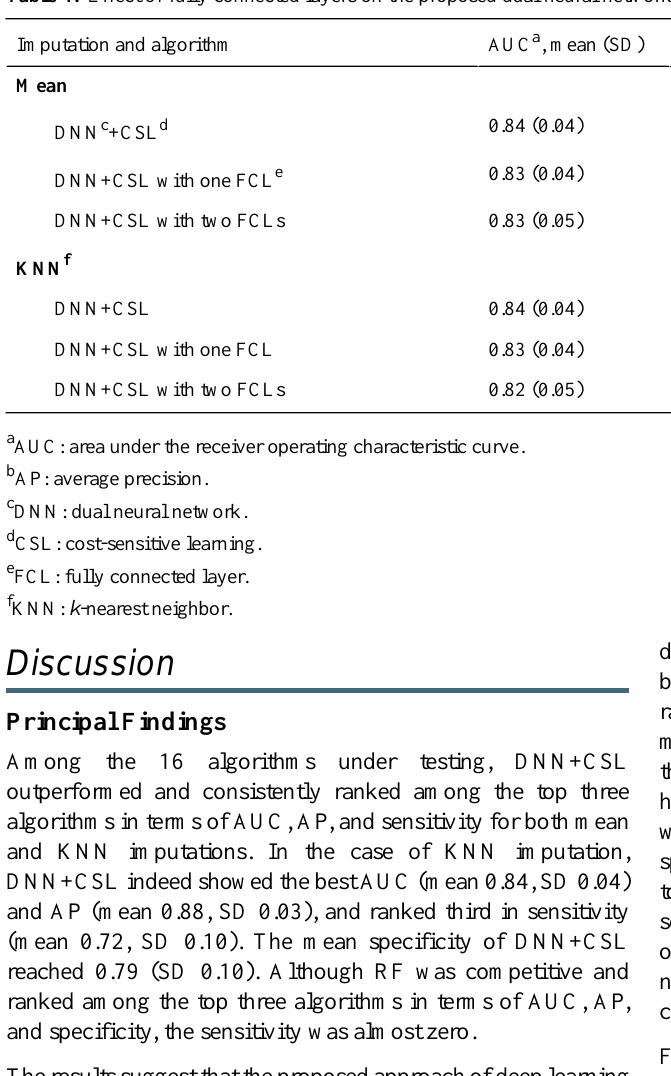
Table 4. Effect of fully connected layers on the proposed dual neural network plus cost-sensitive learning